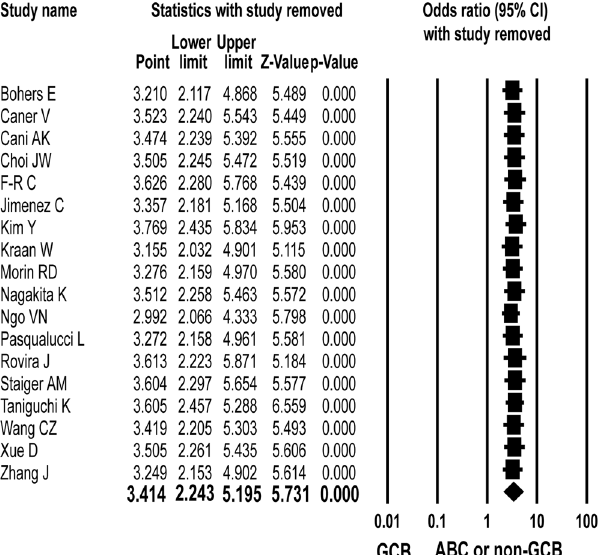
Figure 4. Sensitivity analysis of meta-analysis for the association between MYD88 L265P mutation and ABC or non-GCB subtype of diffuse large B-cell lymphoma. When each study is sequentially removed and meta- analysis is repeated with the remaining studies, the pooled odds ratios (ORs) remain almost the same.